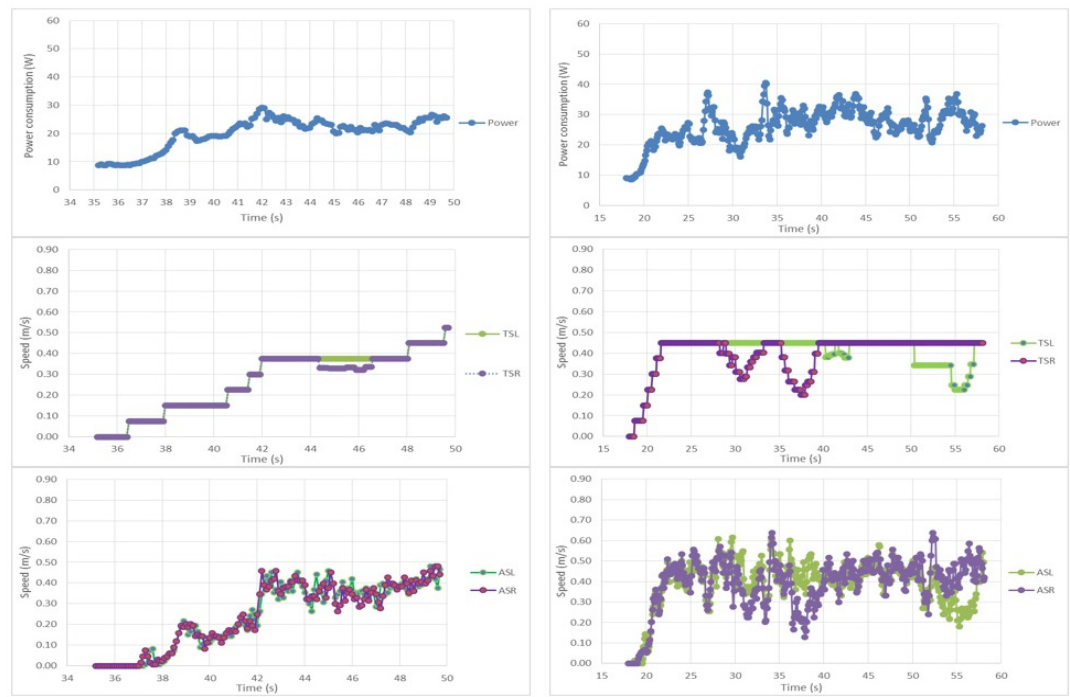
Figure 12. Detailed recordings of the dynamic behavior of the robotic vehicle, from the low-level control unit perspective in two cases: on smooth terrains while loaded ( left part) and on comparatively rough terrains while unloaded ( right part).